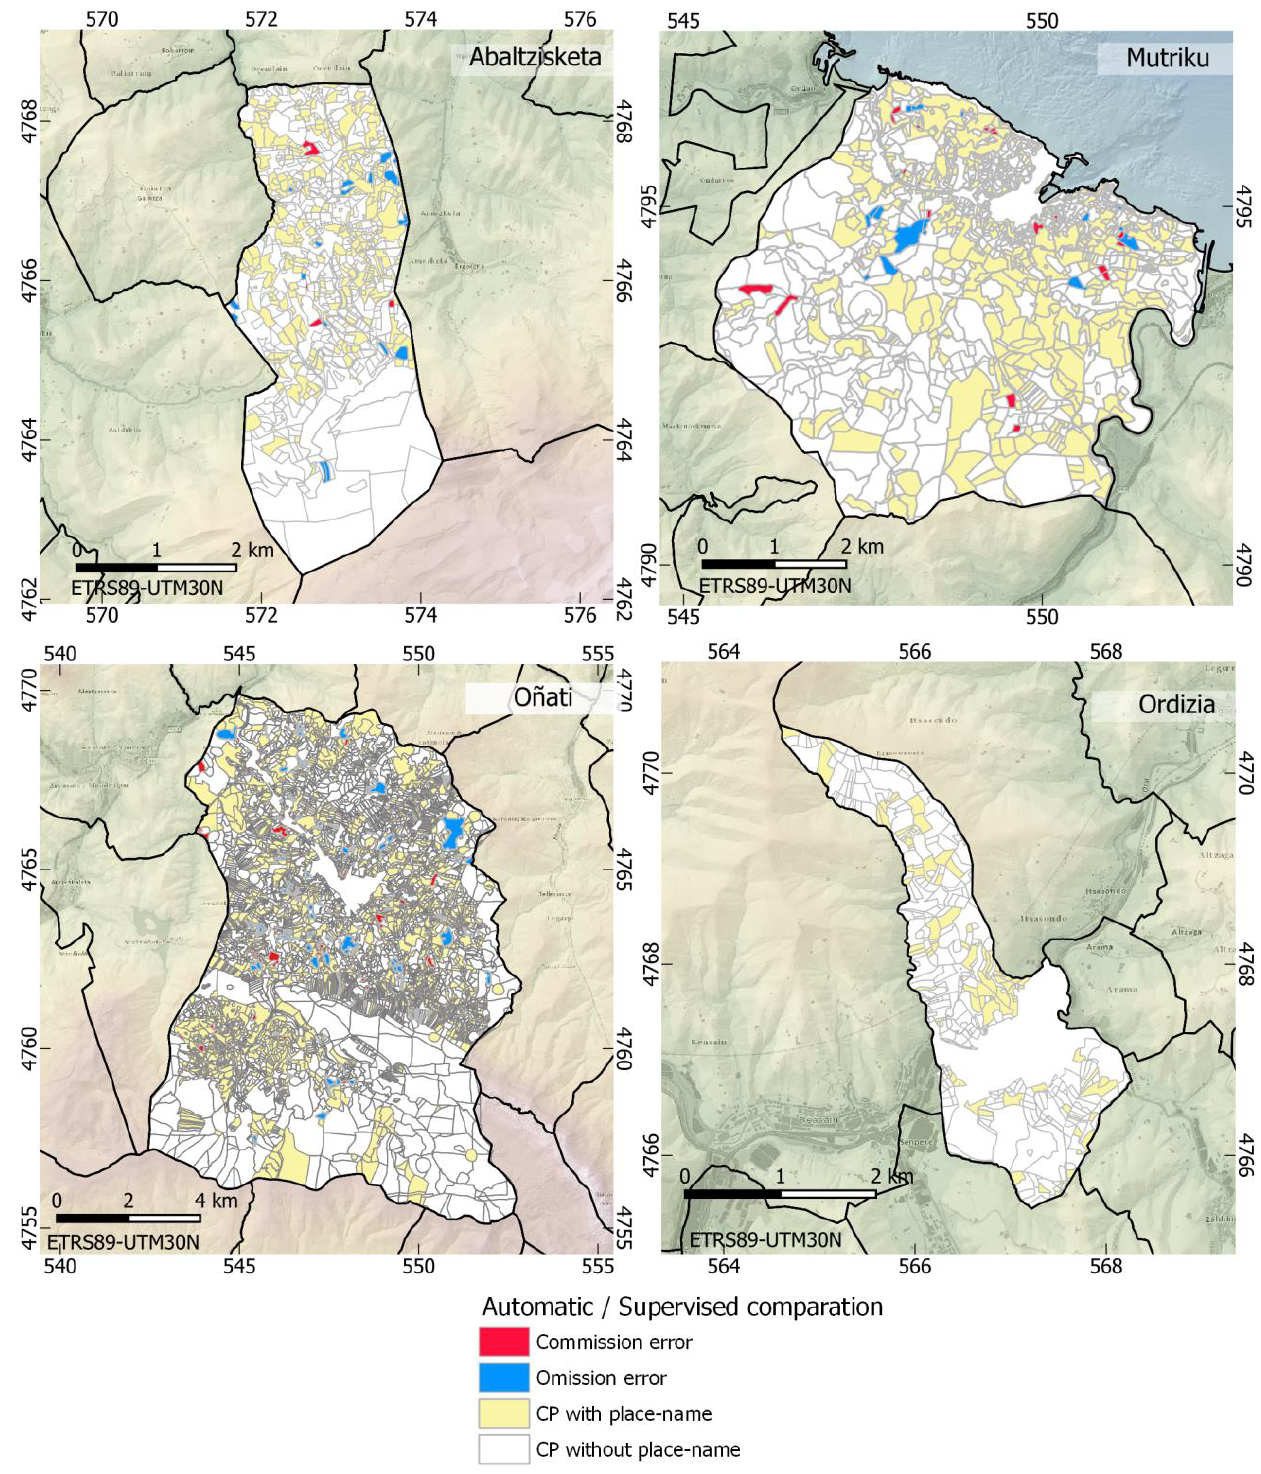
Figure 8. Omission and commission errors in the selected cadastral parcels. Frame coordinates in km.